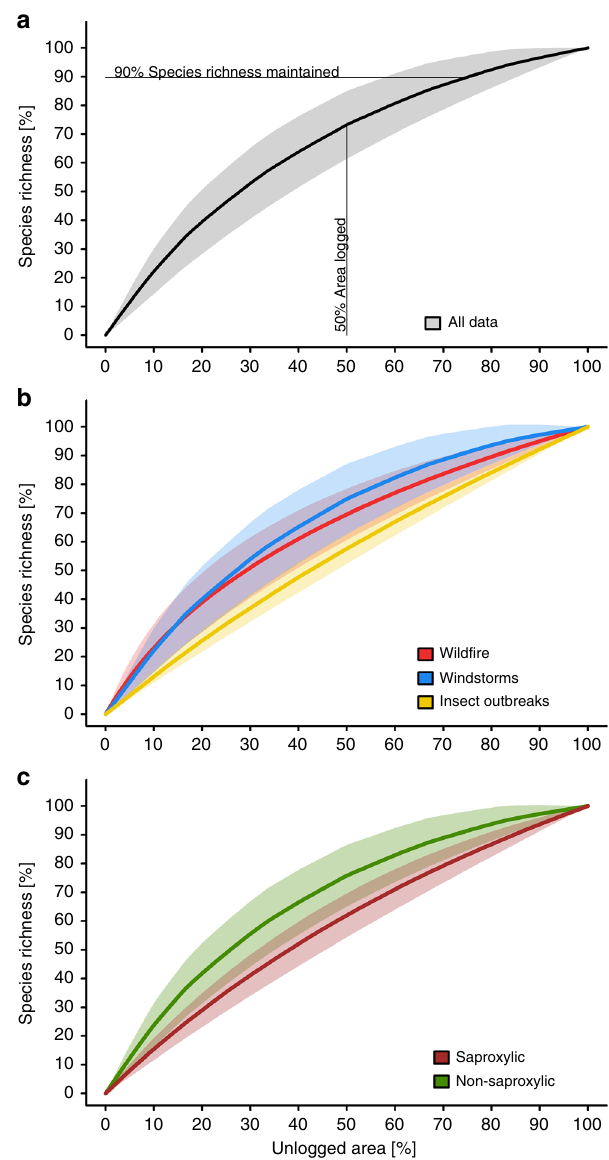
Fig. 3 Response of species richness to different retention levels in salvage logging. Mean and standard deviation (shading) of richness of species unique to naturally disturbed, unlogged plots that would be maintained under varying portions of naturally disturbed forest excluded from salvage logging. The solid lines (means) are analogous to the solid green line from the hypothetical community in Fig. 1, indicating the mean response of 201 individual species matrices with ( a ) all data pooled, ( b ) datasets separated into different disturbance types, and ( c ) datasets separated into saproxylic and non-saproxylic taxa. Source data are provided as a Source Data fi